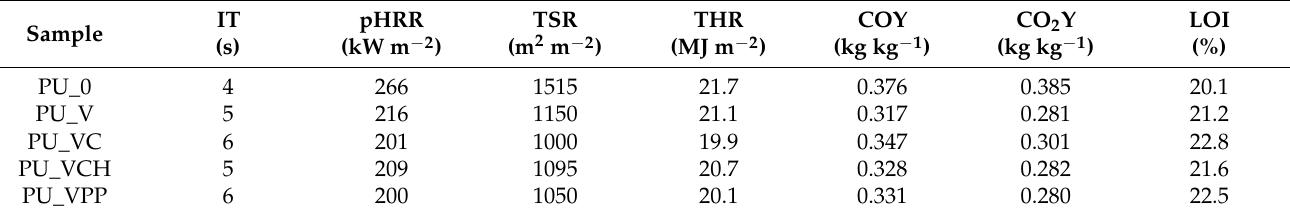
Table 4. Flame-retardant properties of PU